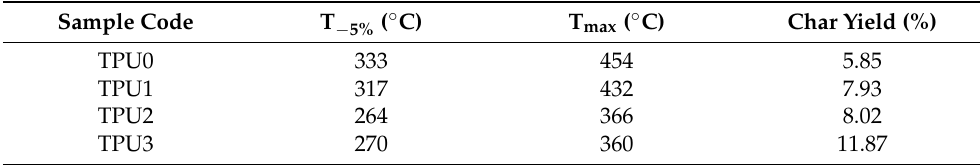
Figure 10. TG ( a ) and DTG ( b ) curves of pure TPU and TPU composites. Table 3. Thermogravimetry data of pure TPU and TPU